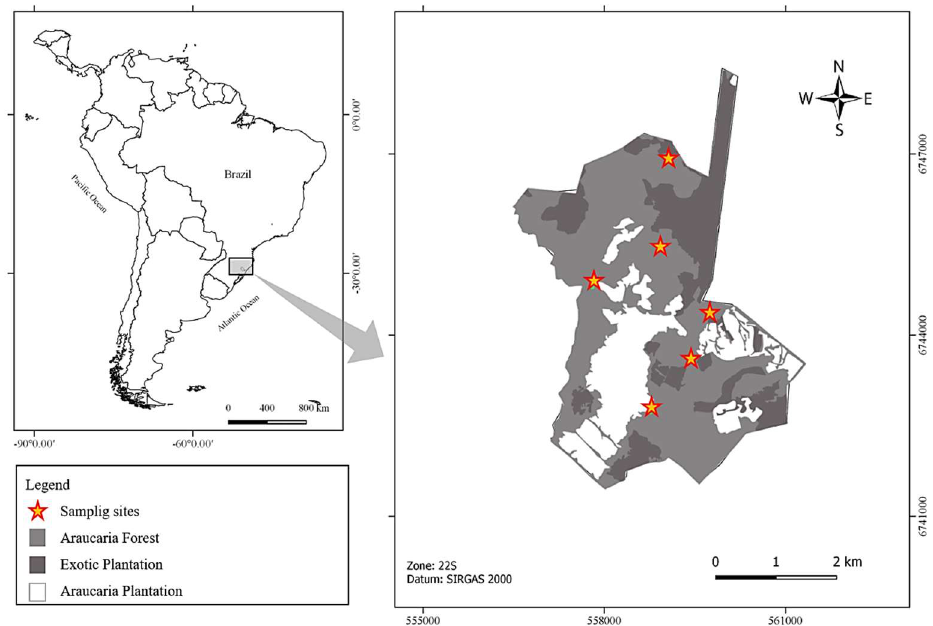
Figure 1. Map showing the location of the study area in the Rio Grande do Sul State, southern Brazil. Samples were carried out with Van Someren–Rydon bait traps [41] in two periods, the first between November 2016 and March 2017, and the second between October 2017 and March 2018, representing the best period for butterfly sampling in the subtropical Atlantic Forest [2]. In both periods, data were collected monthly, and the traps remained open for about 8 days. We used six transects in Araucaria Forest, distant, at least 600 m from each other, with ten bait traps in each transect, totaling 60 traps. In each transect, five traps were placed in the canopy (~15 m above the ground, inside canopy tree crowns), alternating with five in the understory (1.5 m above the ground), at a horizontal distance of 20 m from each other. Each set of five bait traps per stratum composed a sampling unit. The baits consisted of a mixture of mashed banana and sugarcane juice, fermented for 48 h before sampling [41]. Traps were checked every 48 h, with baits replaced, and captured butterflies were identified in the field, also determining sex, marking with sequential Arabian numbers with a permanent pen, and then releasing all individuals. This mark–release procedure avoids the recounting of individuals during each sampling occasion. Exceptions were cases of notably difficult species identification or the need for vouchers (three specimens per species), which were collected for posterior identification. The voucher species